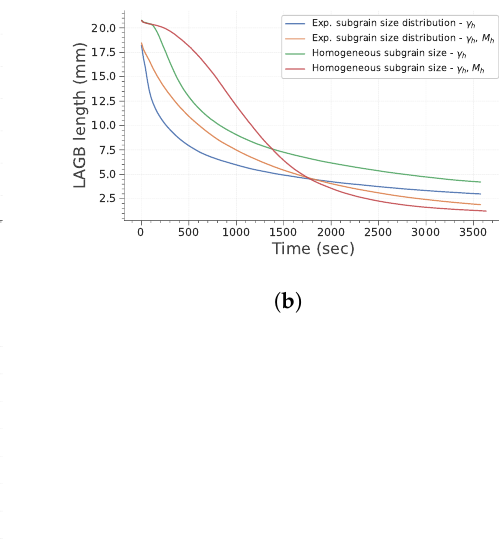
Figure 6. Evolution of subgrain average ECD as a function of time.